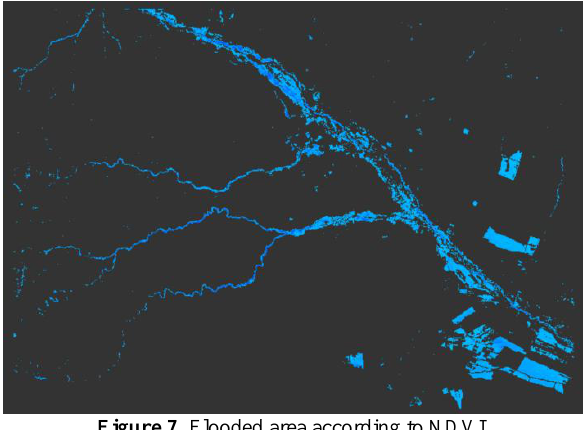
Figure 7. Flooded area according to NDVI